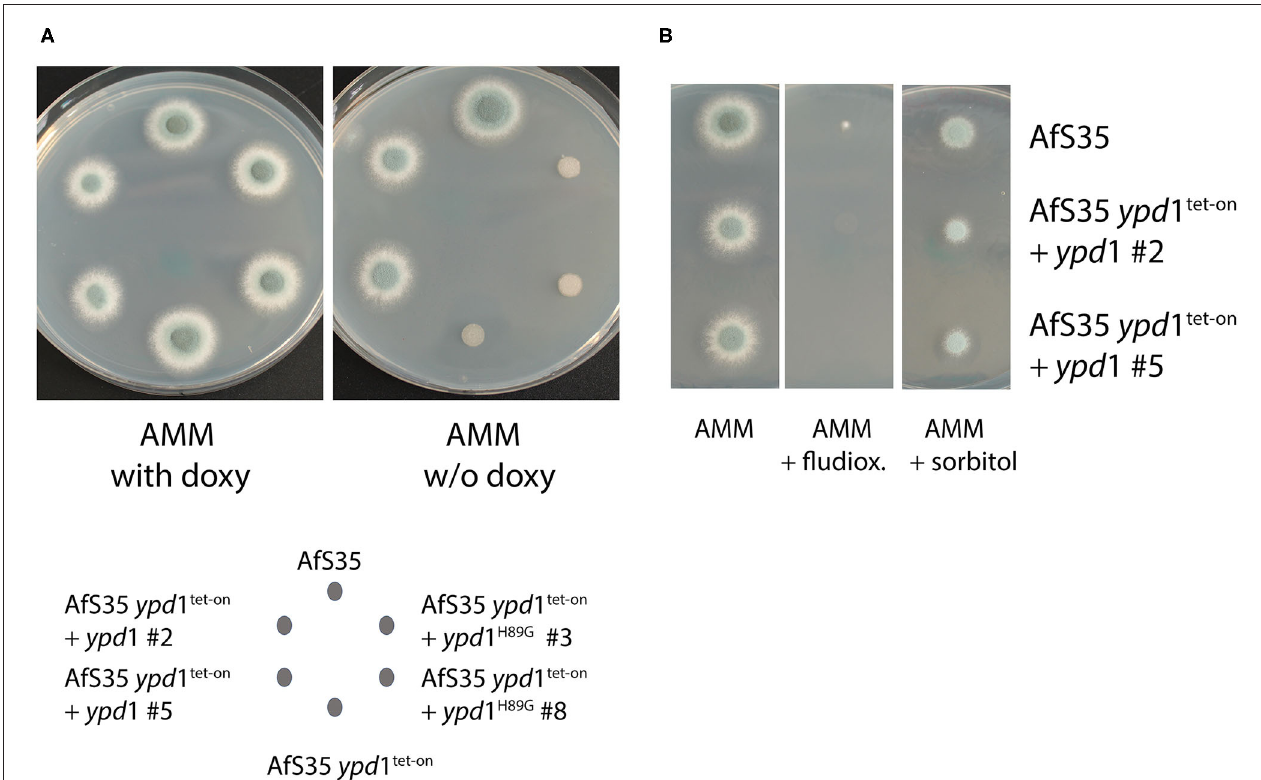
FIGURE 4 | The conserved His residue of the HPt domain is essential for the biological function of A. fumigatus Ypd1. We expressed the native ypd 1 gene or its derivative encoding Ypd1 H89G in the AfS35 ypd 1 tet − on mutant. Two clones of each mutant strain were tested. On AMM plates without doxy, the ypd 1 wild type gene, but not the mutated form restored the growth of the AfS35 ypd 1 tet − on strain (A) . The wild type allele furthermore let to a sensitivity to fludioxonil (1 µ g/ml) and enabled growth of the mutant in the presence of 1.2M sorbitol (B) . Each colony was derived from a spot containing 5 × 10 4 conidia applied in 2.5 µ l.